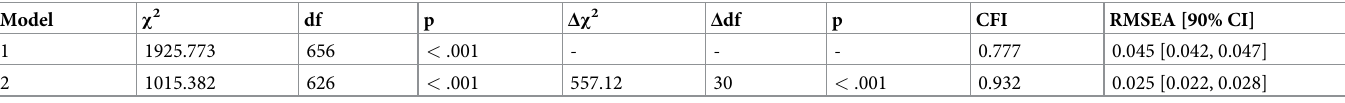
Table 4. Robust fit statistics for the nested models, including chi-square statistic, df, chi-square difference tests, CFI and RMSEA with 90% CI (N = 1950).